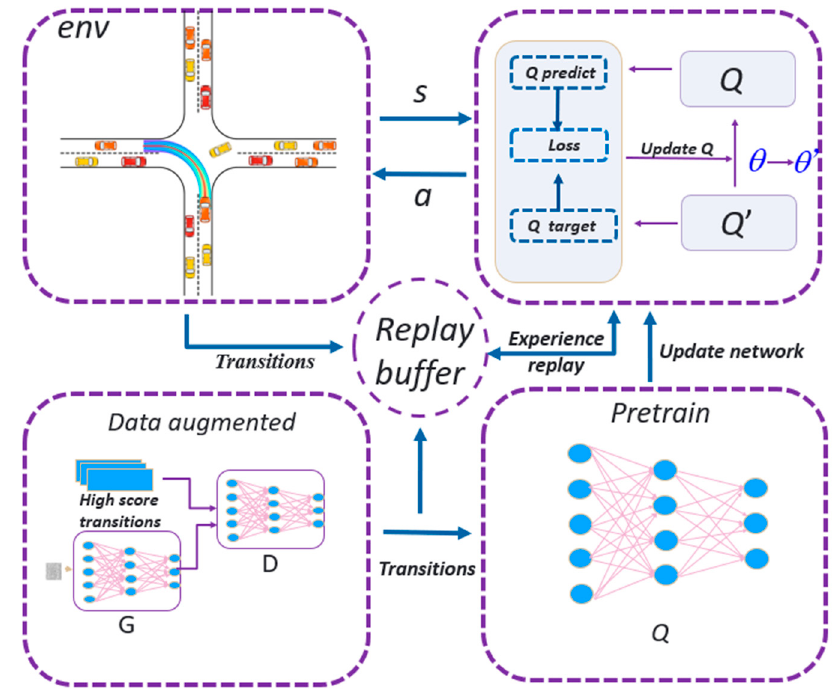
Figure 2. The framework of RLfGD.